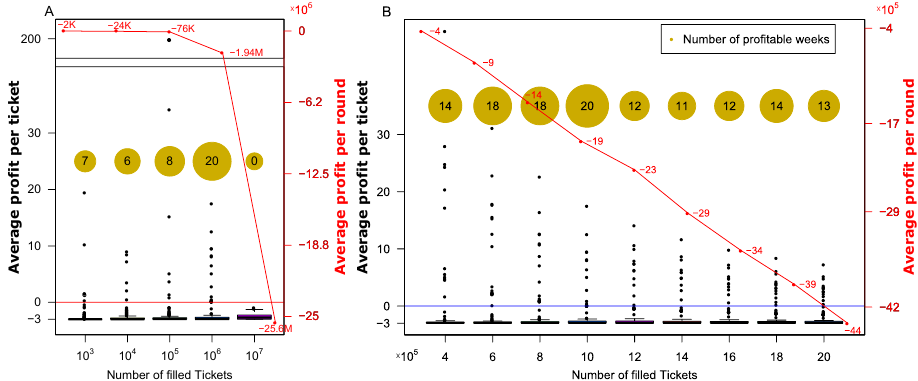
Figure 3. Number of profitable rounds and the mean profitability averaged over all rounds. The x-axis corresponds to the number of filled forms sent in each round according to the described algorithm. The yellow circles correspond to the number of profitable rounds. Each dot corresponds to a single round, and the associated y-axis (to the left in black) is the average profit per form. The average profit per round is indicated on the right y-axis in red. ( A ) shows the results for 10 3 ≤ N ≤ 10 7 , and ( B ) zooms in on 4 · 10 5 ≤ N ≤ 2 · 10 6